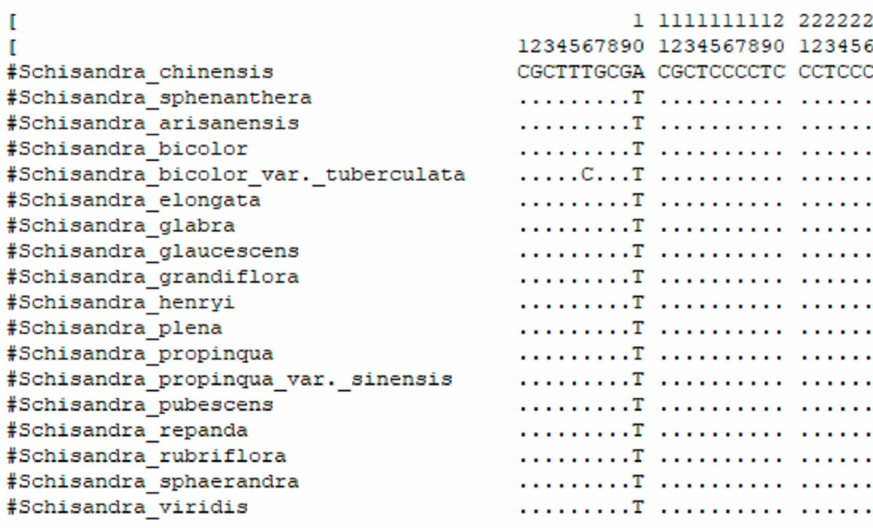
Figure 3. Alignment of the 26-bp nucleotide conserved